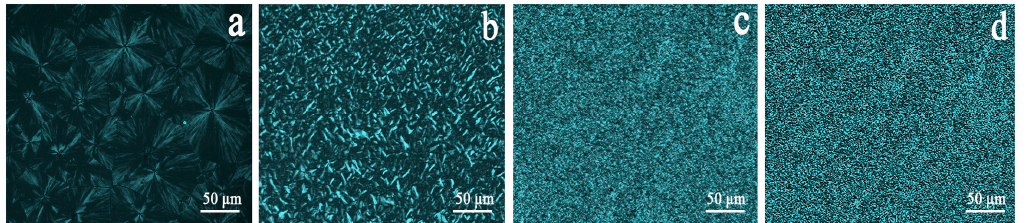
Figure 8. POM micrographs for the iPP/A12C-Li composites under isothermal crystallization temperature of 128 °C: ( a ) iPP; ( b ) iPP-1; ( c ) iPP-3; ( d ) iPP/NA-21.